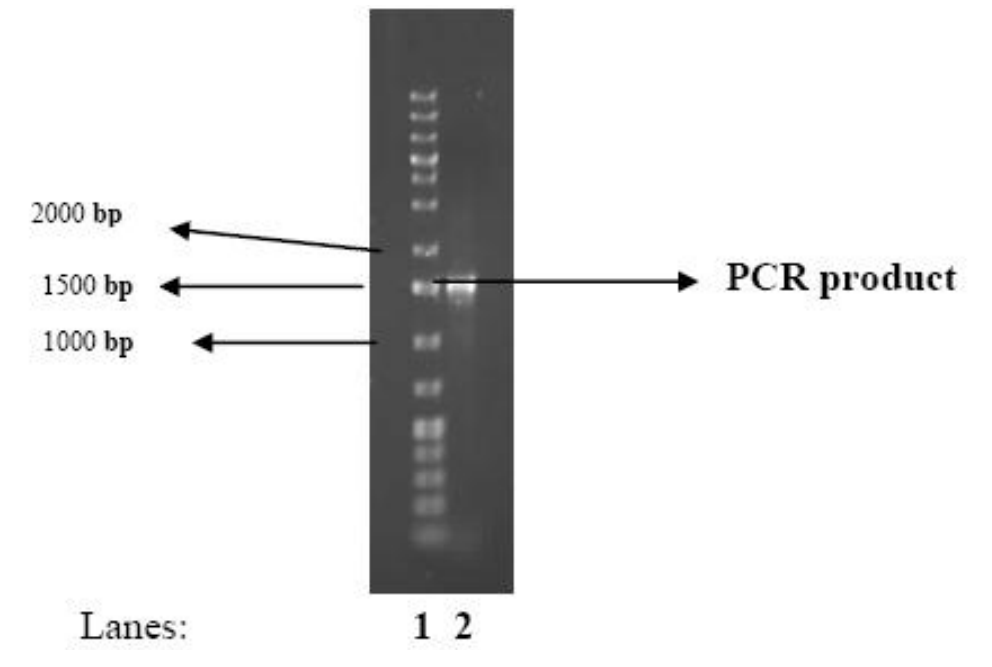
Figure 1. Agarose gel electrophoresis of PCR product of Arthrobacter sp. Raats. Lanes: 1 = Ladder; 2 = PCR